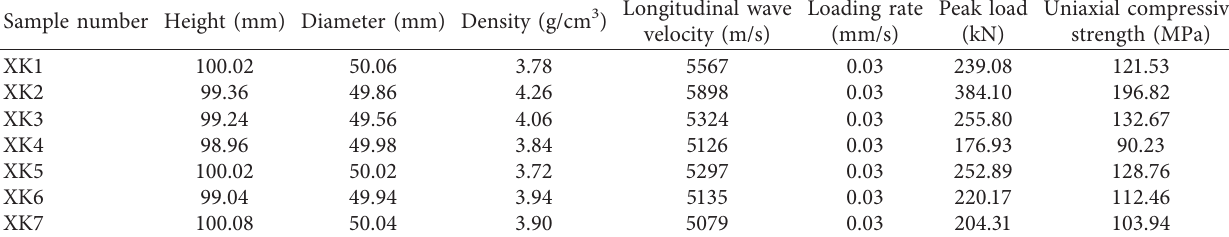
Table 1: Test scheme and results of deep skarn under uniaxial compression.